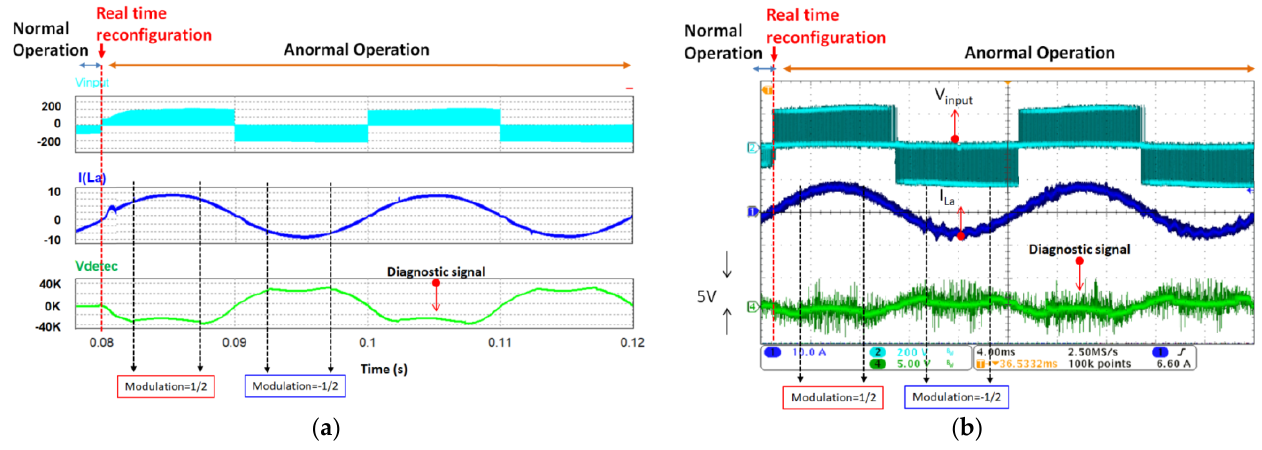
Figure 19. Short-circuit fault condition on T 2 with reconfiguration. ( a ) Simulation result; ( b ) experiment result.